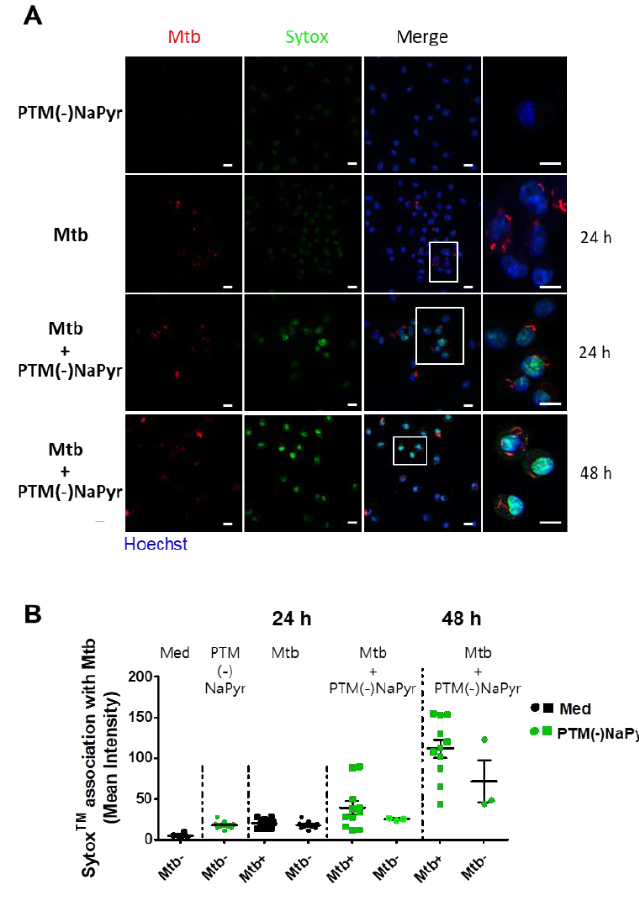
Figure 7. Loss of ERFP Mtb -infected primary macrophage membrane caused by PTM. ( A ) Association between BMDMs and SYTOx™ in uninfected cells incubated for 24 h in 8-fold-diluted PTM without NaPyr, Mtb -infected cells (MOI 1), and ERPF Mtb -infected cells incubated in 8-fold-diluted PTM without NaPyr. Last image is Mtb -infected cells incubated for 48 h in PTM without NaPyr. Images show stained nuclei (blue), ERFP Mtb (red), and SYTOx™ (green). (Right panels) Magnification highlights the association between SYTOx™ and ERFP Mtb -infected cells. Scale bar, 10 µ m. ( B ) Quantitation of ERFP Mtb and SYTOx™ association in macrophages. Numbers of bacteria analyzed for each condition and proportions of Mtb that are considered positive for SYTOx™ association are shown. Mean fluorescence intensity was quantified using LAS X 3.7. Data are means ± SEM of one representative experiment (n = 3).